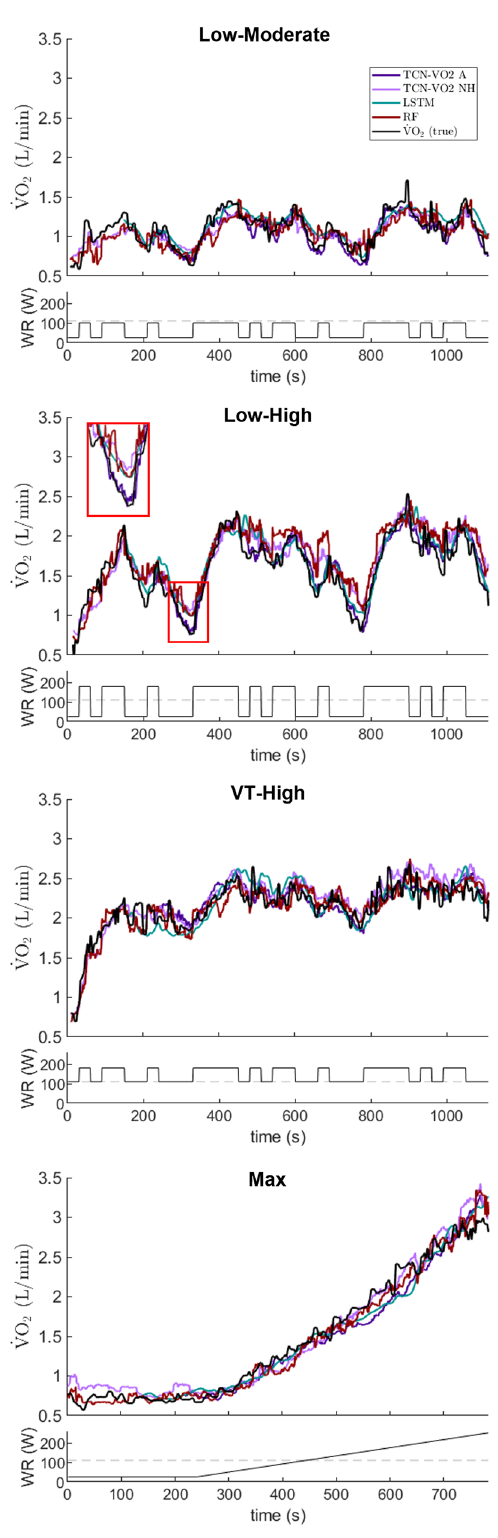
Fig. 4 Results for a representative participant across the four exercise protocols. Prediction curves are shown for VO2-TCN (proposed) with the lowest validation loss (VO2-TCN A) and 1 s receptive fi eld (VO2-TCN NH), random forest (RF) 21 , and stacked long short-term memory network (LSTM) 23 . Dashed gray line represents the participant ’ s ventilatory